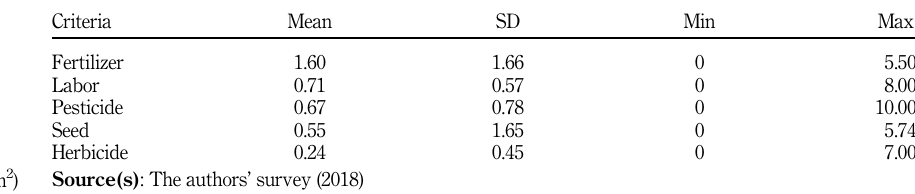
Table 3. Input cost of rice